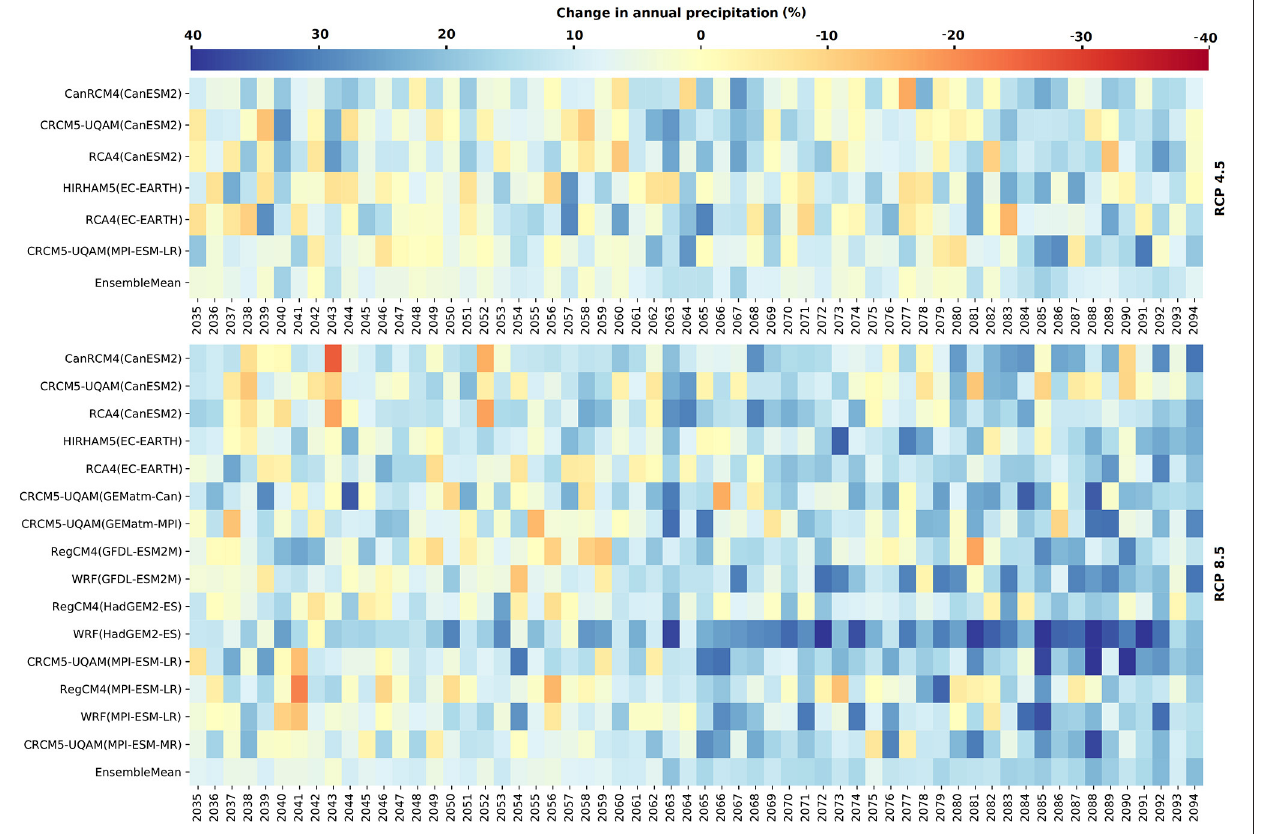
is supplied to the crops by external means (e.g., surface or sub-surface